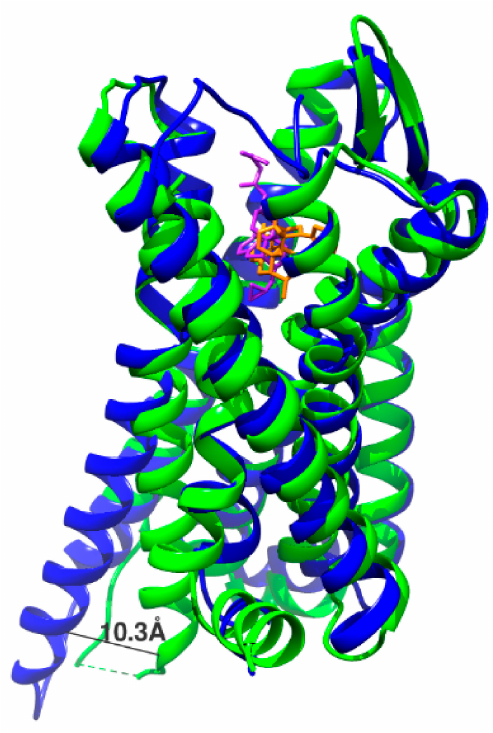
Figure 2. Activation of µ OR displaces TM6 by 10.3 Å. The inactive state is in blue and is bound to the